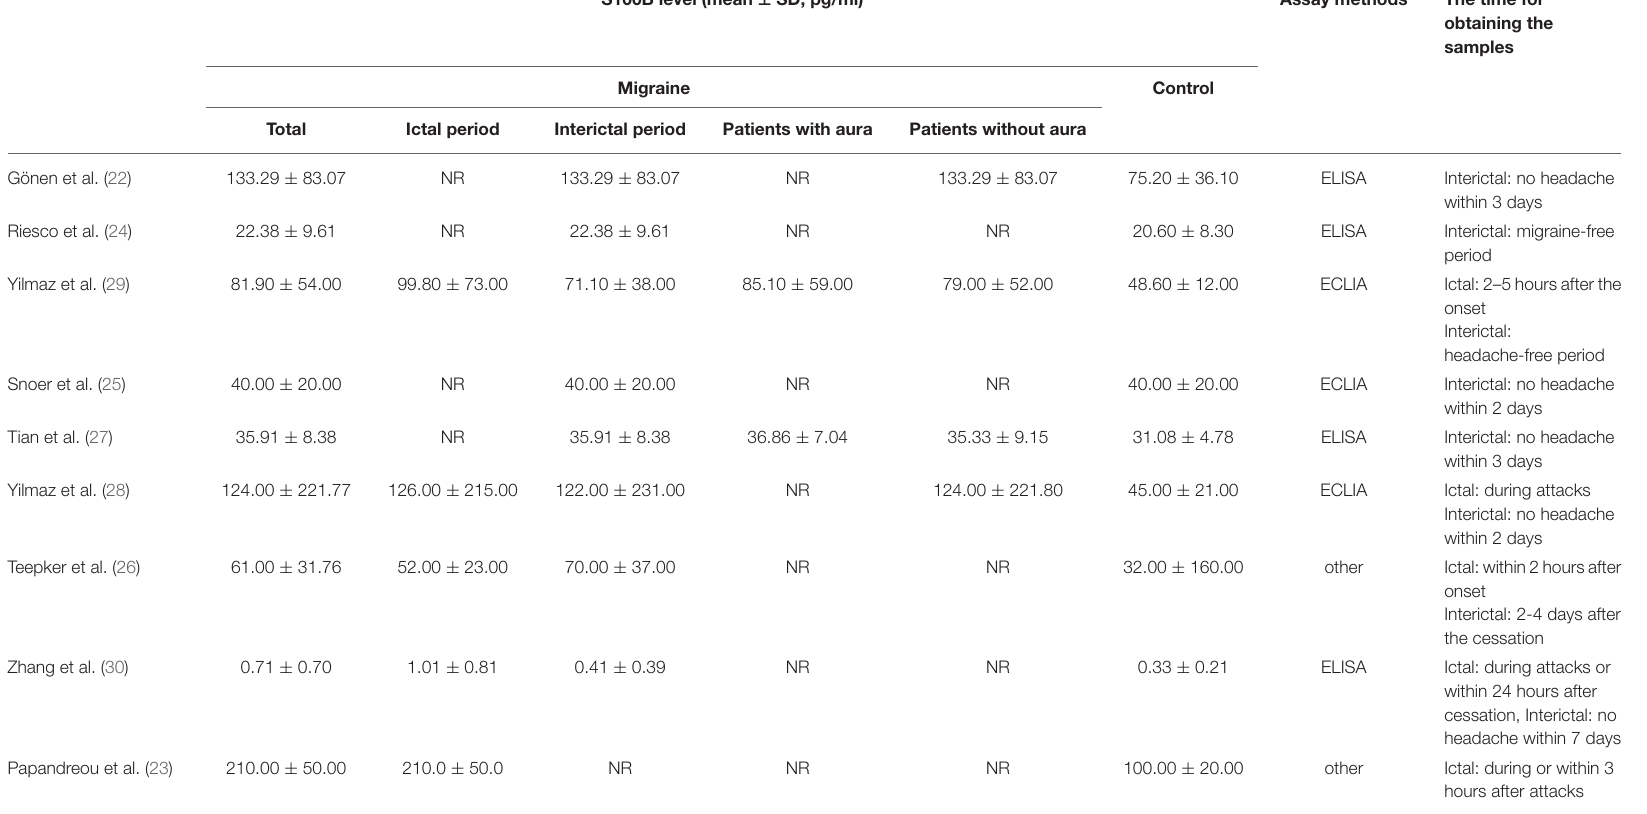
TABLE 2 | Comparison of S100B